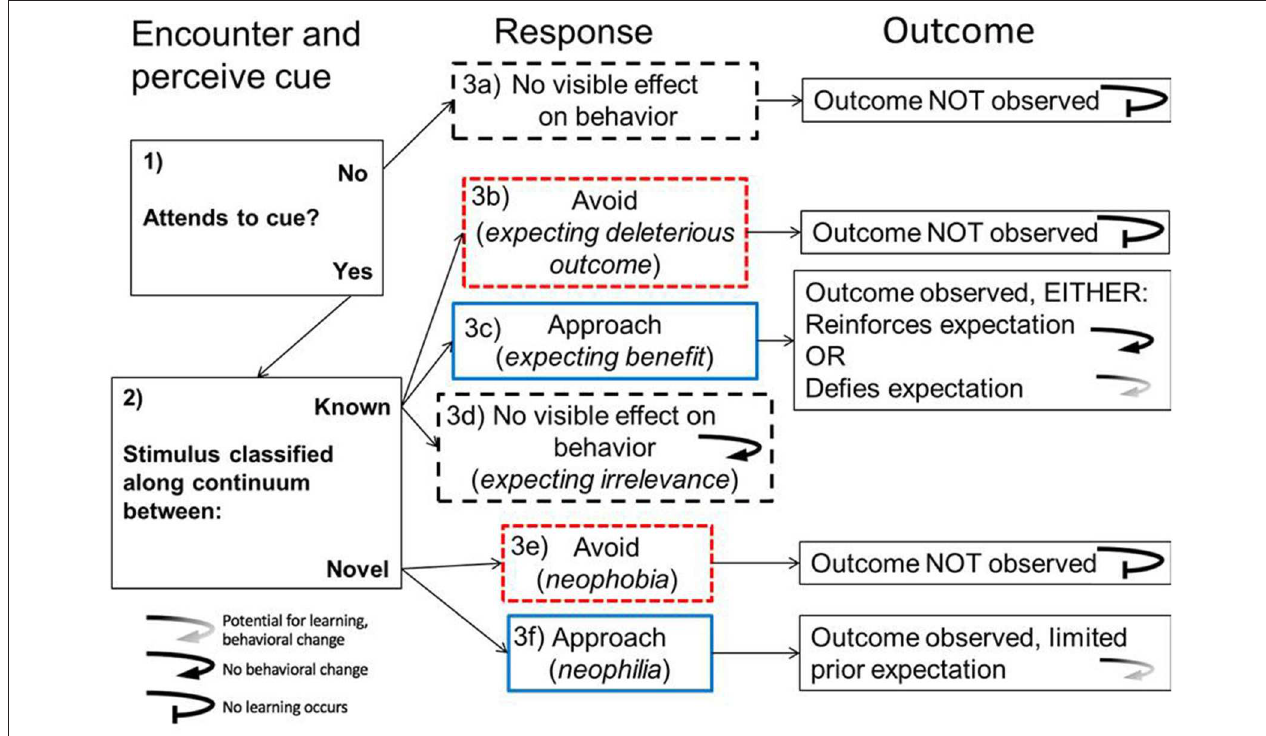
FIGURE 1 | Stages of responses to HIREC and potential for learning. Different underlying motivations can promote approach, avoidance and apparent neutrality toward a stimulus. The outcome of the animal’s behavior will direct future responses to that same stimulus. Even when an animal makes the wrong choice, if the animal is not able to observe the outcome or does not perceive the outcome to be relevant to the preceding behavior, then it will not learn about it. Straight arrows imply the flow of response. Curved arrows symbolize the different responses animals will have on subsequent encounters. The greater the extent that an experience defines expectations, the higher likelihood there will be learning. In cases where there is no behavioral change, learning may not be overtly observed, but animals could still gain information that reinforces details of their response or associated